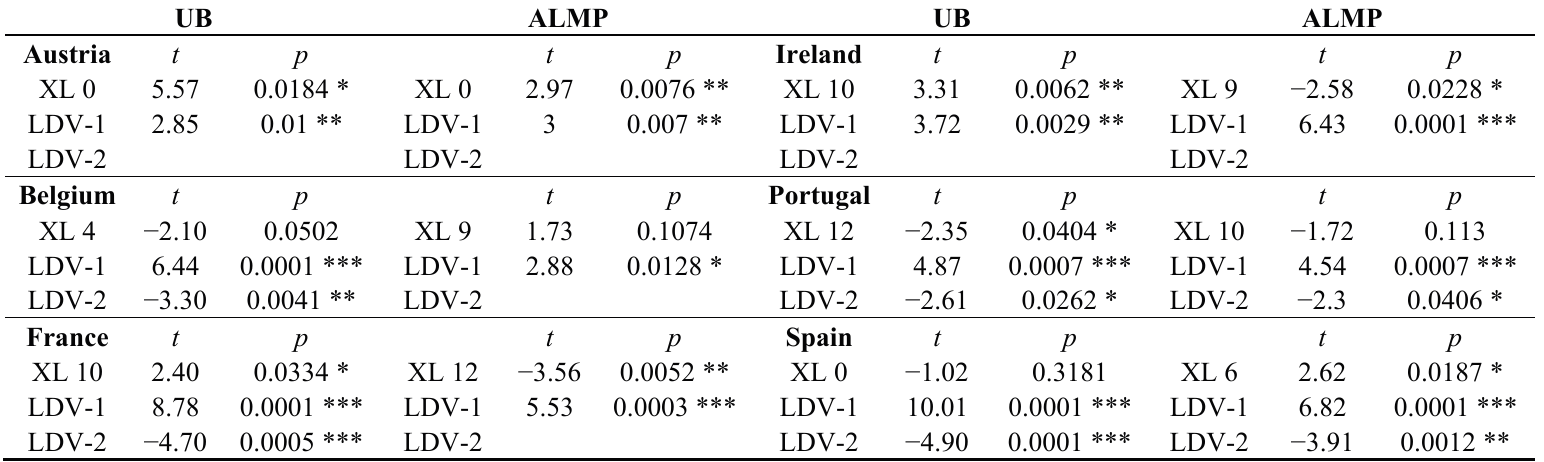
Table 3. The countries where the institutional stickiness was more significant than capital